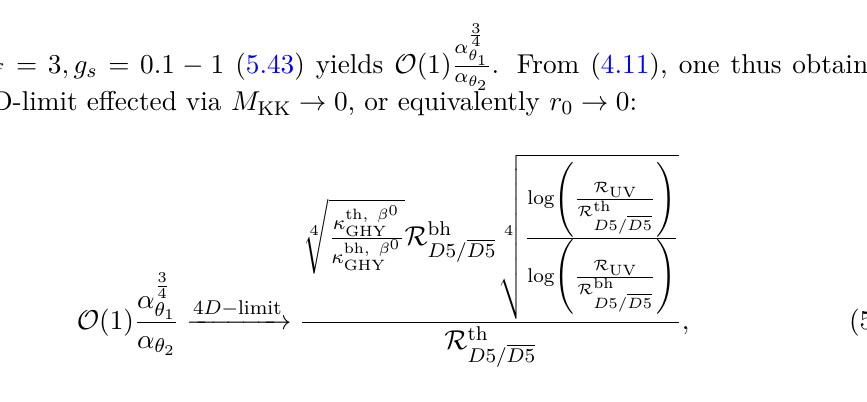
Figure 2 . Plot S connected (blue) and S disconnected (orange) versus l ( r ∗ )